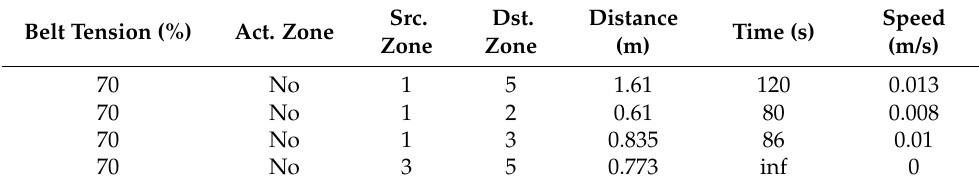
Table 4. Dynamic case results for 70% belt tension.